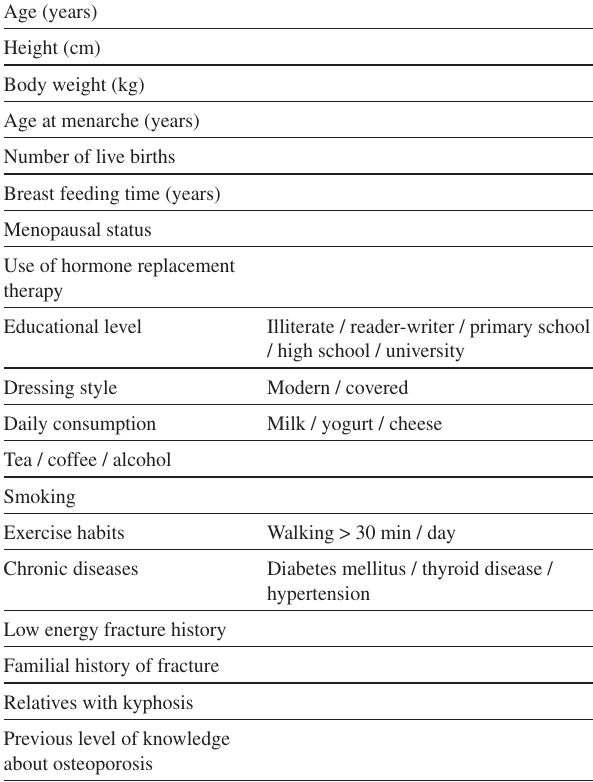
Table 1 - Questionnaire for risk